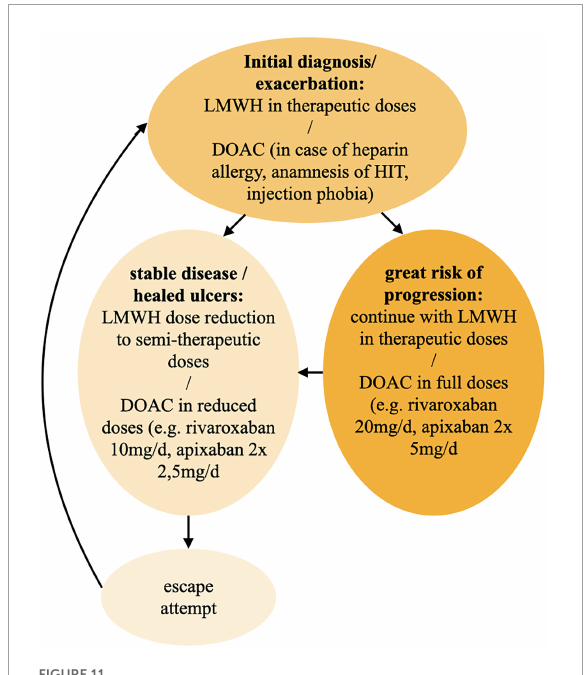
FIGURE11 Therapy algorithm for 1st line anticoagulation. DOAC, direct oral anticoagulant; HIT, heparin-induced thrombocytopenia; LMWH, low molecular weight